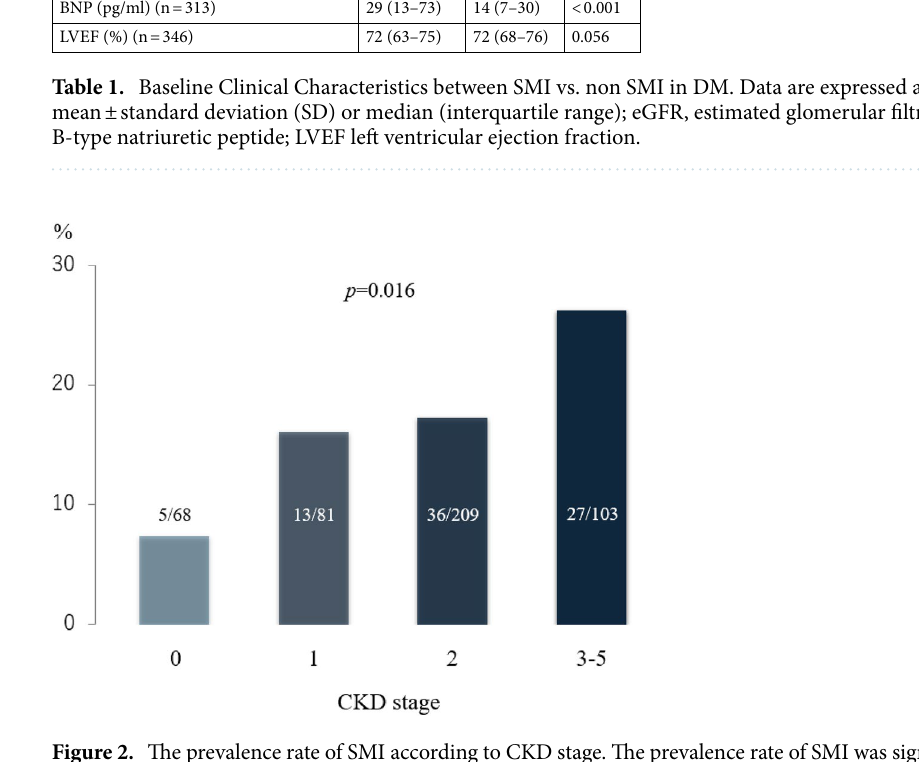
Figure 2. The prevalence rate of SMI according to CKD stage. The prevalence rate of SMI was significantly higher in patients with advanced CKD. SMI silent myocardial ischaemia, CKD chronic kidney